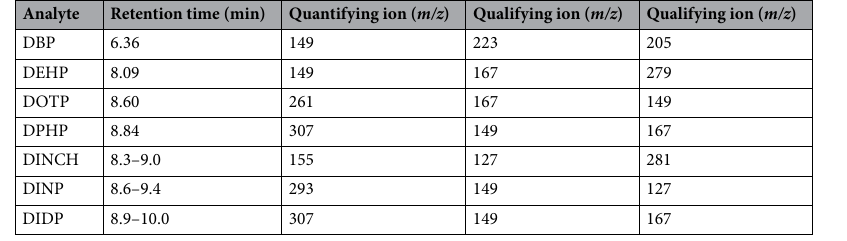
Table 1. Selected ions for SIM mode acquisition